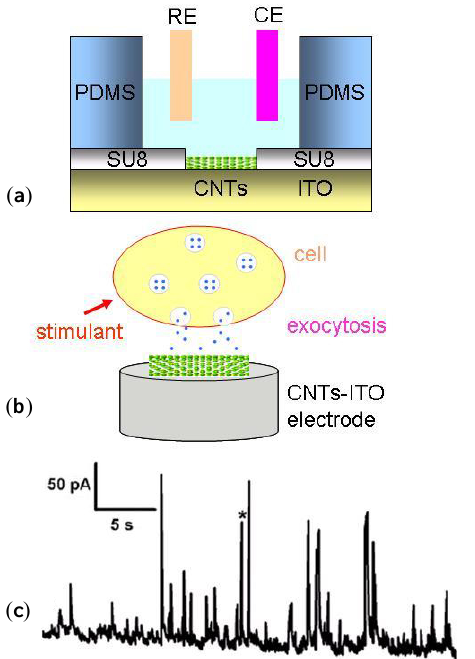
Figure 27. ( a ) Cross-sectional schematic of the electrochemical sensor with CNTs-ITO microelectrode. Ag/AgCl acted as reference electrode (RE) and Pt wire as counter electrode (CE); ( b ) Schematic of the single-cell release monitoring with the CNTs modified ITO electrode; ( c ) The amperometric response to stimulation from a single cell. (Reprinted from [183]. © 2011, with permission from